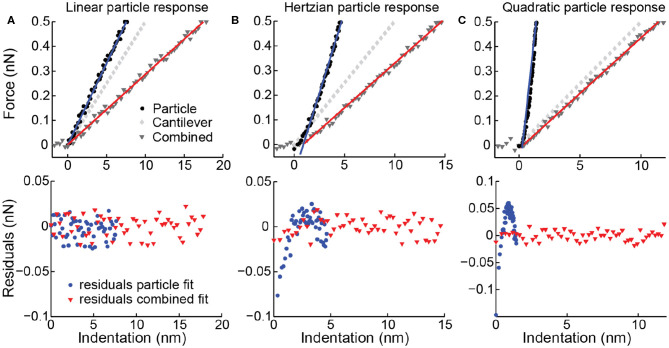
Simulated force distance curves (FZCs) and force indentation curves. Upper panels simulated deformation of a particle (corresponding to a force indentation curve), deformation of the cantilever and combined deformation (corresponding to an FZC) for three different particles. (A) Linear particle response with k = 0.067 N/m, (B) Hertzian response (0.05x1.5) and (C) quadratic response (0.25x2). Simulated spring constant of the cantilever is 0.05 N/m, and noise is simulated with std. of 10 pN. Linear fits to the indentation (blue) and combined data (red) shown as solid lines. Lower panels residuals belonging to the fits of the combined response (red triangles) and to the particle response (blue circles). (B,C) Residuals of FZC fits do not show a trend or deviation from a normal distribution (p-value of Kolmogorov-Smirnov (KS)-test 0.86 respectively 0.76), so the non-linearity of the particle response is not detected. Residuals of force indentation curve fits do show a clear trend and deviation from a normal distribution (p-value of KS-test 0.019 respectively <10−10), correctly indicating that the linear model is not applicable.